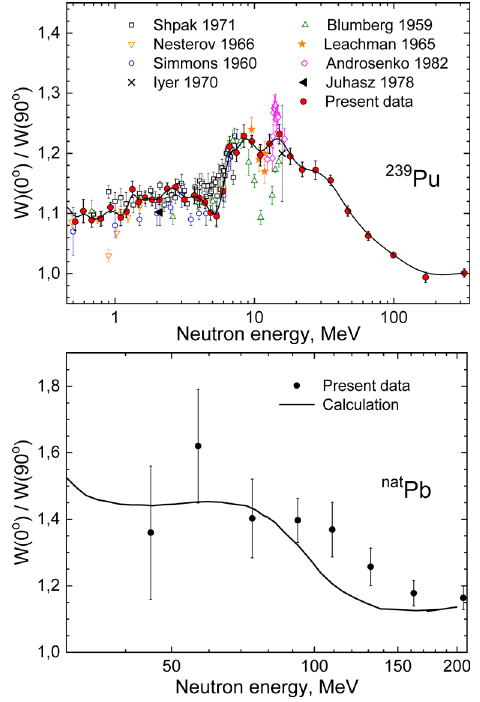
Figure 3. Anisotropy of FFs for 239 Pu (top) compared with ex- perimental data from [10–13, 15–18] and for nat Pb (bottom). Er- ror bars are the statistical errors. The solid line for 239 Pu is an eye guide to the experimental data. The solid line for nat Pb is the result of the model calculation [22].